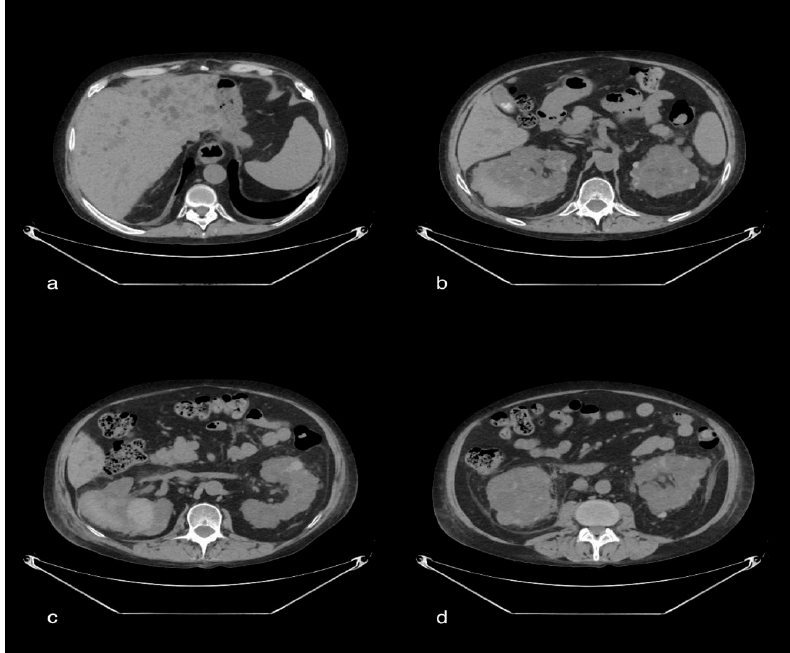
Figure 5. A 47-year-old male patient with multiple cystic formations in the liver and both kidneys. In particular, the kidneys show increased volume and completely subverted parenchymal structure. In the right posterior pararenal area, there is a large spontaneously hyperdense area inseparable from the adjacent renal parenchyma, which is compatible with a hematoma. On this side, there is an inhomogeneous appearance of the perirenal fat. Thickening of the left posterior pararenal fascia. Distended gallbladder, with evidence of multiple endoluminal lithiazed formations ( b ). 3.5.3. Discussion The elevation of C-reactive protein and inflammatory cytokines in COVID-19 pa- tients cause a severe extrapulmonary and hematologic clinical presentation that can pro- voke hematologic complications (such as thrombosis or bleeding). Common bleeding sites in COVID-19 patients include chest wall, muscles, adrenal glands, brain, liver and retro peritoneum. The high incidence of hypercoagulation in COVID-19 patients increase the mortality rate. Antithrombotic drugs such as heparin are highly recommended. Anticoag- ulants are the most common cause of retroperitoneal bleeding in COVID-19 patients [34]. The clinical symptoms vary from mild persistent pain to devastating acute abdominal con- ditions, such as acute appendicitis or perforated viscus or dissecting aneurysm. Lenk’s triad consists of acute flank pain, tenderness and hypovolemia. Therefore, a contrast-en- hanced CT scan is necessary in order to confirm the diagnosis or to rule out another diag- nosis. CT scan has higher sensitivity and specificity for diagnosing renal tumor/abscess [35]. 3.6. Case 6: Pneumomediastinum 3.6.1. Clinical History A 48-year-old old male patient exhibited no known comorbidities. He presented to the respiratory emergency department with non-productive cough, asthenia, myalgia and fever (39 °C). An oropharyngeal PCR swab was performed and tested positive for COVID- 19 pneumonia. An arterial blood gas (ABG) test performed and it reported: pH 7.5, pO 2 56.2 mmHg, pCO 2 31.8 mmHg, HCO 3 -26.2 mEq/L, and Lac 2.2 mmol/L.